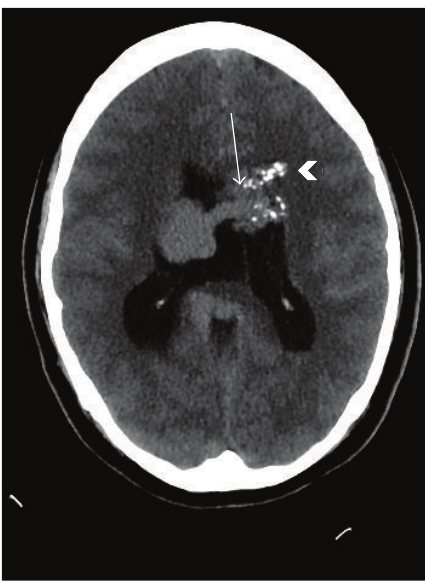
Figure 7: Axial noncontrast enhanced CT of the brain demonstrat- ing a serpiginous intraventricular structure (arrow) with calcifica- tions (arrowhead).